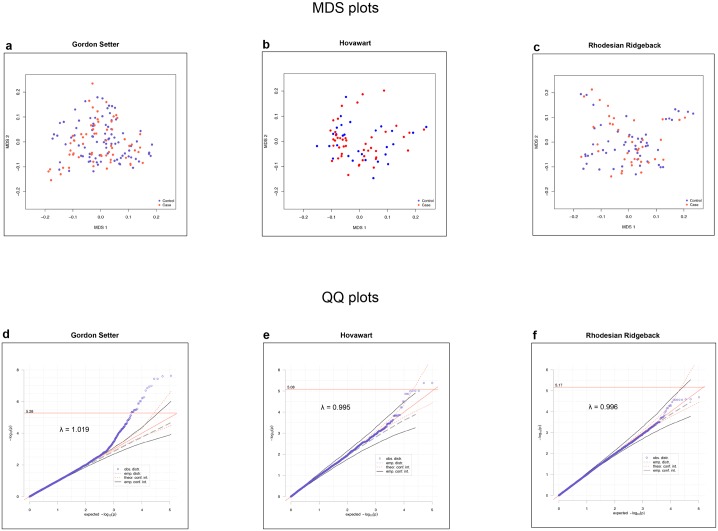
(a-c) MDS plots showing homogenous sample sets without presence of clustered samples in the (a) Gordon Setter (GS), (b) Hovawart (HV) and (c) Rhodesian Ridgeback (RR) breed cohorts. (d-f) QQ plots showing no inflation after the mixed model approach, and the empirical genome-wide significance thresholds (indicated by red lines and their corresponding values) and empirical 95% confidence intervals (CI95) in (d) GS λ = 1.019, (e) HV λ = 0.995 and (f) RR λ = 0.996.